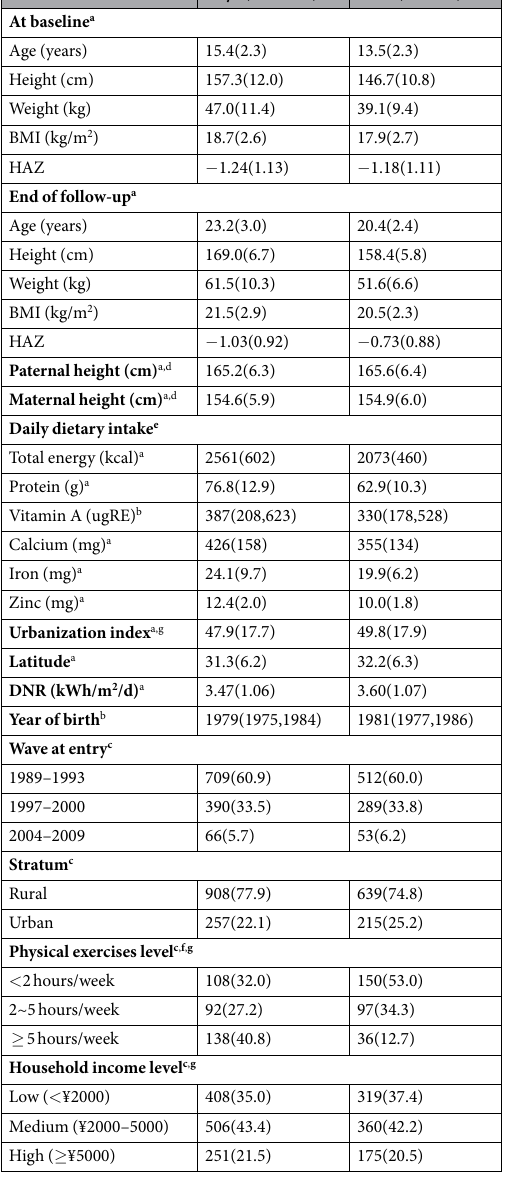
Table 1. Characteristics of adolescent boys and girls with plant-based diet. a Data shown is mean (SD). b Data shown is median (IQR). c Data shown is n (%). d Average height between the baseline and the follow-ups. e Energy adjusted average nutrient intakes during adolescence were estimated from a mean number of 1.8 three-day 24- hour dietary recalls (range: 1–3) obtained during age 12–19 in boys and 10–17 years in girls using the residual method after log transformation. f Data was only collected in and after 1997. g Information was only presented in the baseline. BMI: body mass index; HAZ: height-for-age z -score; DNR: annual average direct normal radiation; SD: standard deviation; IQR: interquartile